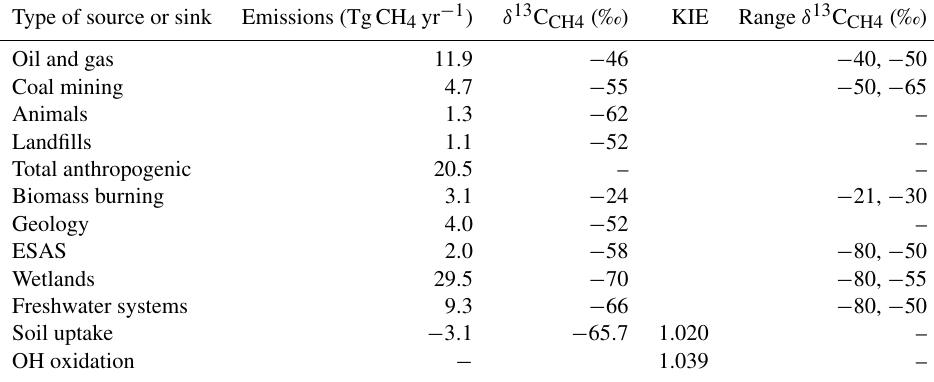
Table 2. Methane emissions and isotopic signatures in the studied domain (see text within Sects. 2.3 and 2.4). Emission and sink fluxes used here are the same as in Thonat et al.